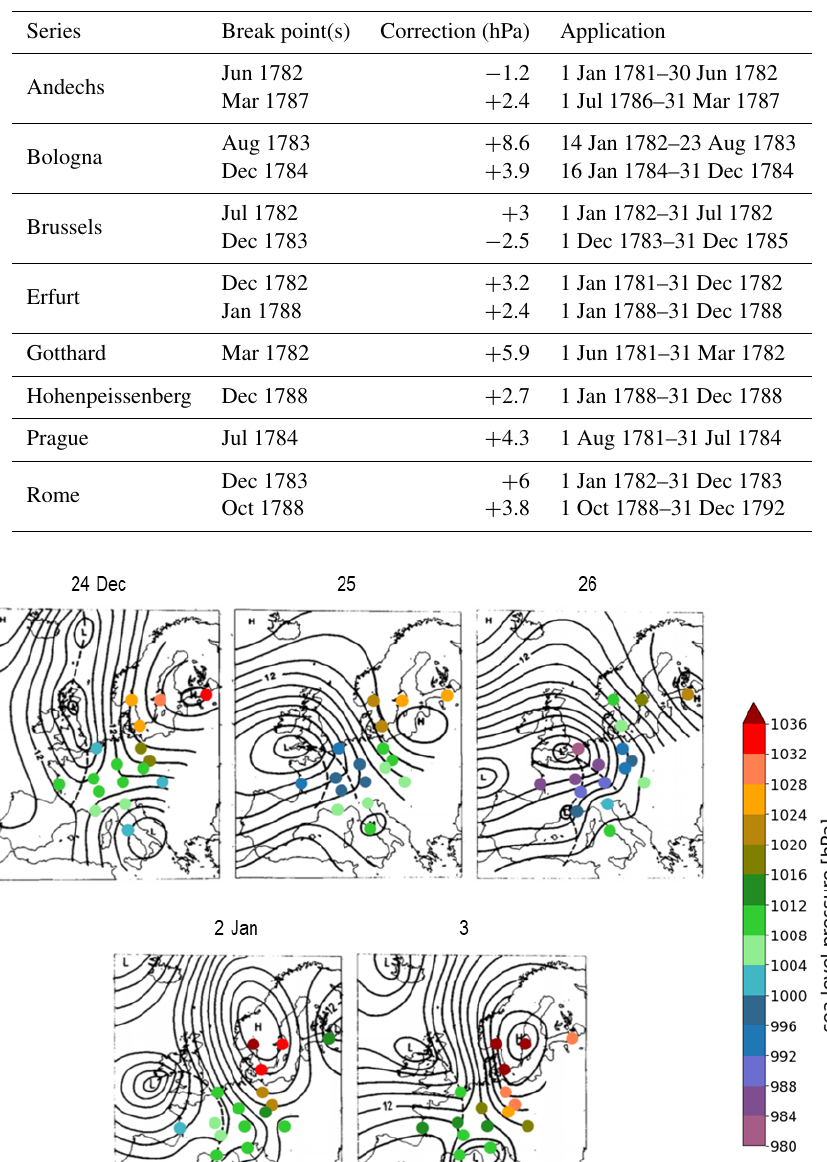
Table 3. Station pressure series for which break points were detected, showing the location in the series where the break point is, the extent of the correction, and where in the series this was applied.